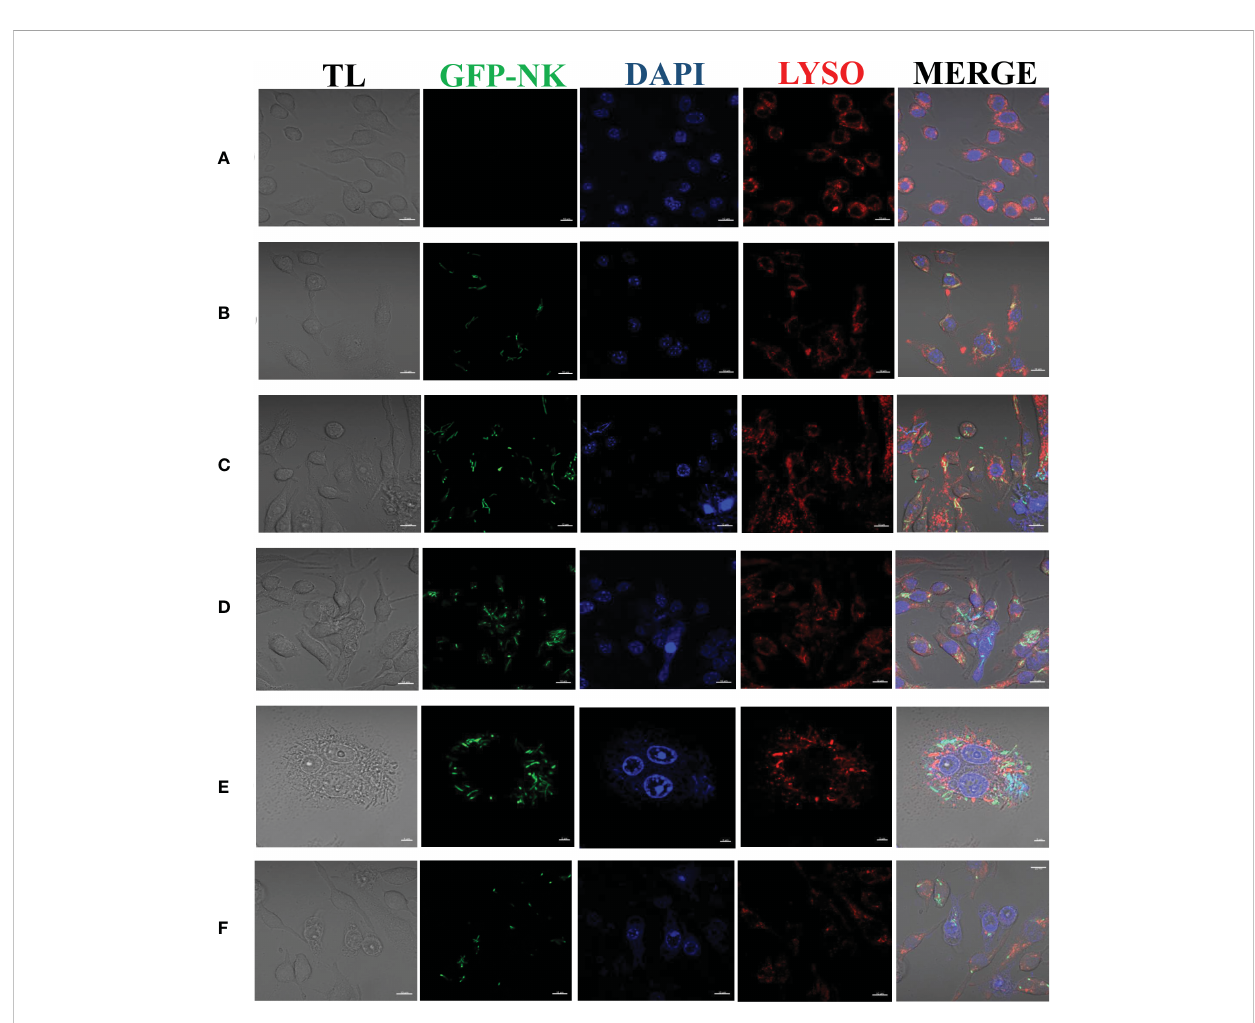
FIGURE 2 Laser confocalization of RAW264.7 infected with GFP- N. seriolae. (A) uninfected cells; (B) 2 hpi; (C) 4 hpi; (D) 6 hpi; (E) 8 hpi; (F) 12 hpi.